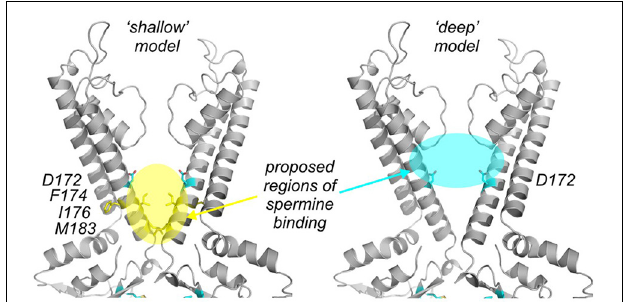
FIGURE 4 | Contrasting models of the deep spermine binding site in Kir2.1. (left panel) The “shalllow model” proposes a binding region “below” the rectification controller position, highlighted in yellow, along with residues in this region that have been demonstrated to reduce polyamine blocker affinity. (right panel) The “deep” model proposes a binding site highlighted in cyan, supported by experiments testing the interactions between polyamine block and modification of substituted pore-lining